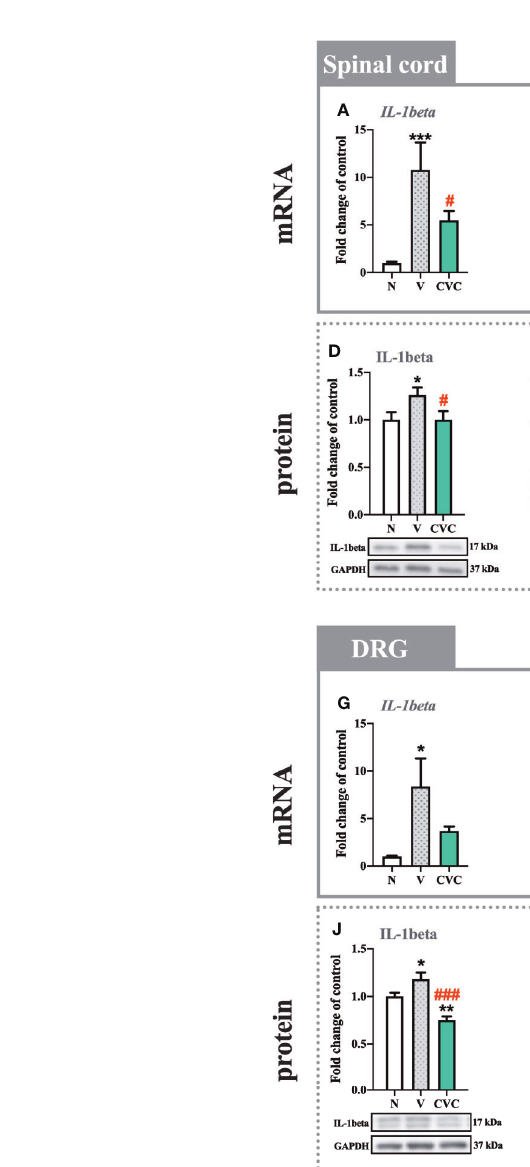
FIGURE 4 | Changes in mRNA (A – C, G – I) and protein (D – F, J – L) levels of IL-1beta, IL-6 and IL-18 in the spinal cord (A – F) and DRG (G – L) on day 7 post CCI after repeated vehicle or cenicriviroc (20 µg/5 µl, i.t. ) administration, measured using RT-qPCR and Western blot method. Data are presented as the mean ± SEM (n = 5 – 10 per group for mRNA analysis and n = 5-7 per group for protein analysis). Intergroup differences were analyzed by ANOVA with Bonferroni ’ s multiple comparisons test. ***p < 0.001, **p < 0.01, *p < 0.05 indicate differences between naive and V-treated/CVC-treated CCI-exposed rats; ### p < 0.001, # p < 0.05 indicate differences between V-treated and CVC-treated CCI-exposed rats. CCI, chronic constriction injury; CVC, cenicriviroc; N, naive; V,